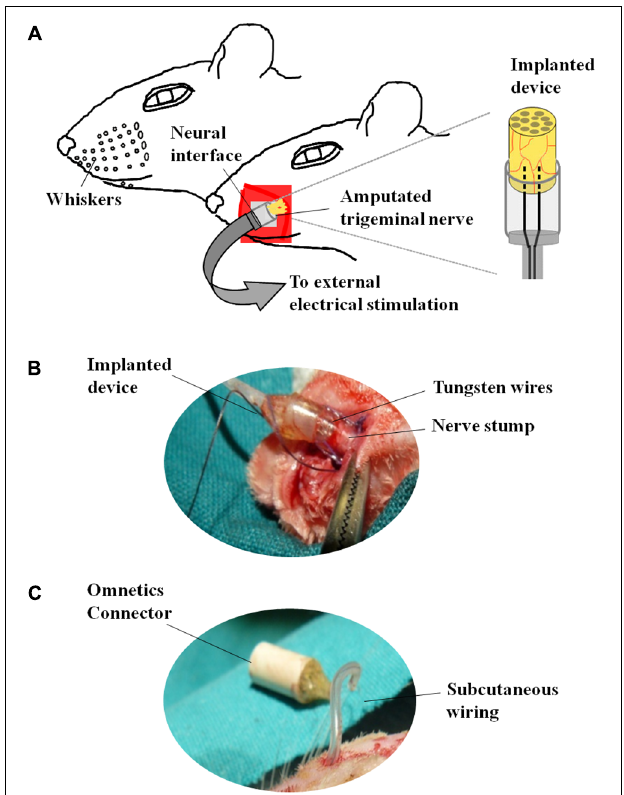
FIGURE 2 | Neuroprosthetic stimulation device. (A) Schematic representation of the implant. (B) After fixing the screws to the skull, the infraorbital nerve is dissected taking all the fascicles that innervate the vibrissae; immediately after cutting, the distal end of the nerve is inserted into the implant and placed in contact with the electrodes; the epineurium is then sutured to the silicone implant. (C) Before the nerve section, the implant is subcutaneously tunneled to connect the skull to the